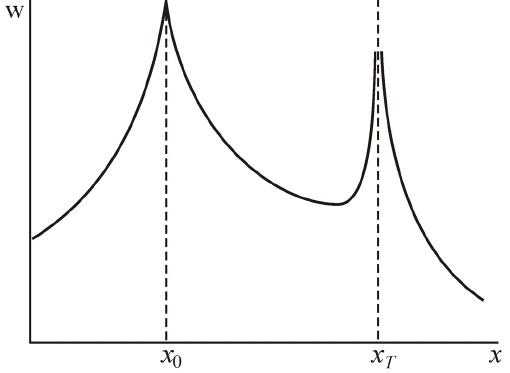
Fig. 1. A surface wave with superposed field line resonance. Here w is the wave energy